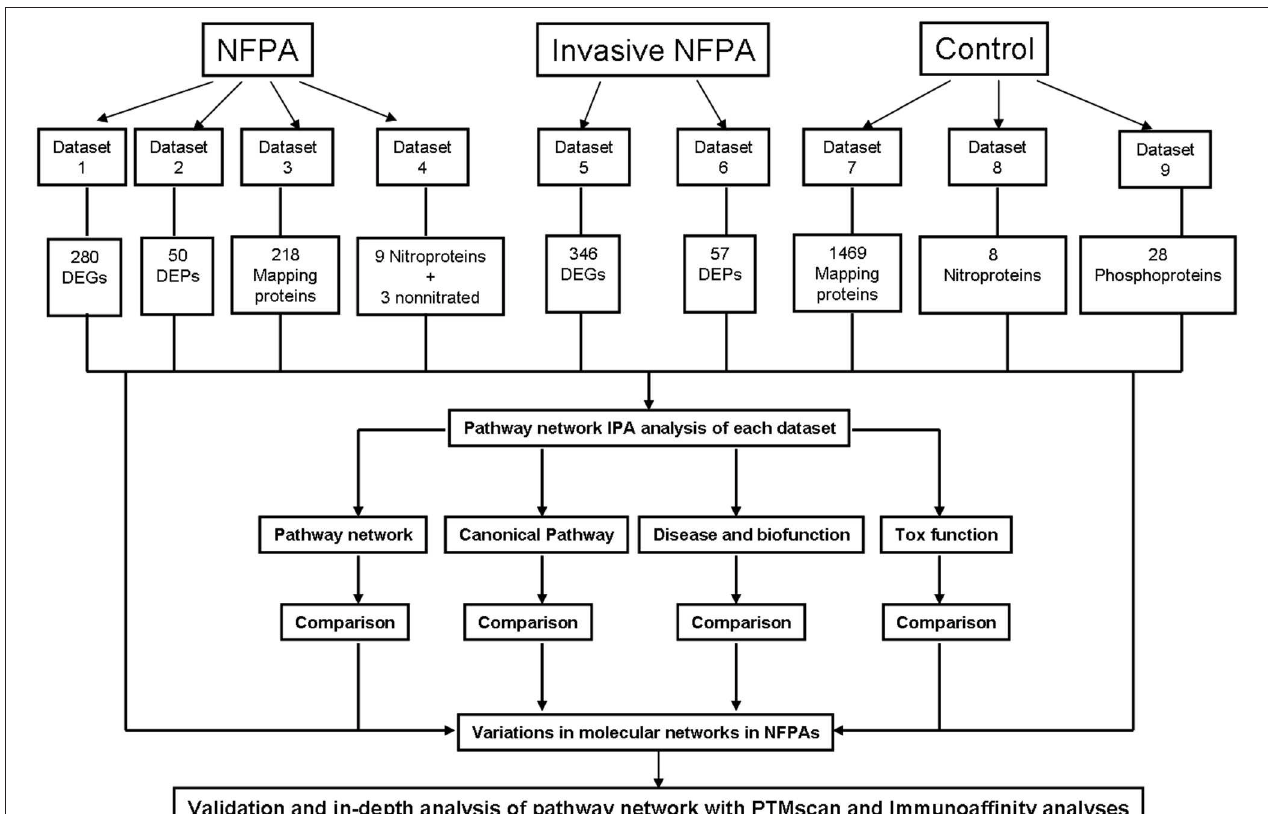
FIGURE 1 | Scheme to construct molecular networks based on an integrative analysis of the documented omics data in NFPAs. DEG, differentially expressed gene; DEP, differentially expressed protein.